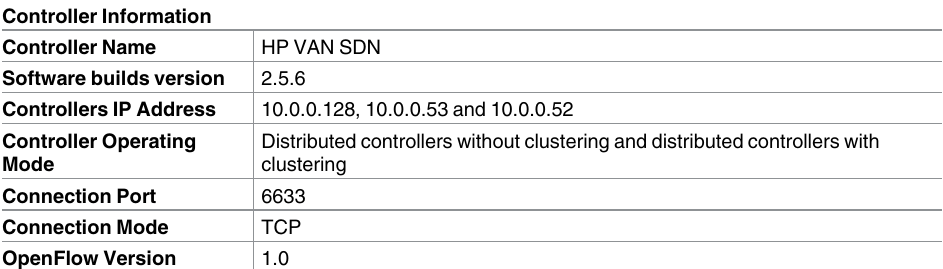
Table 1. HP VAN SDN controller information.